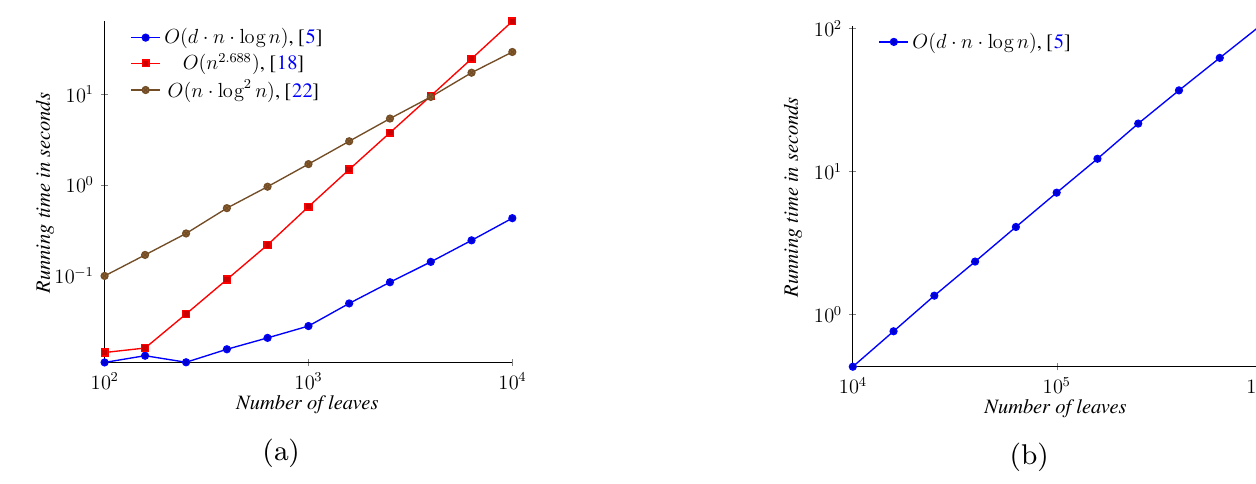
Figure 14. Quartet distance running time on binary trees.